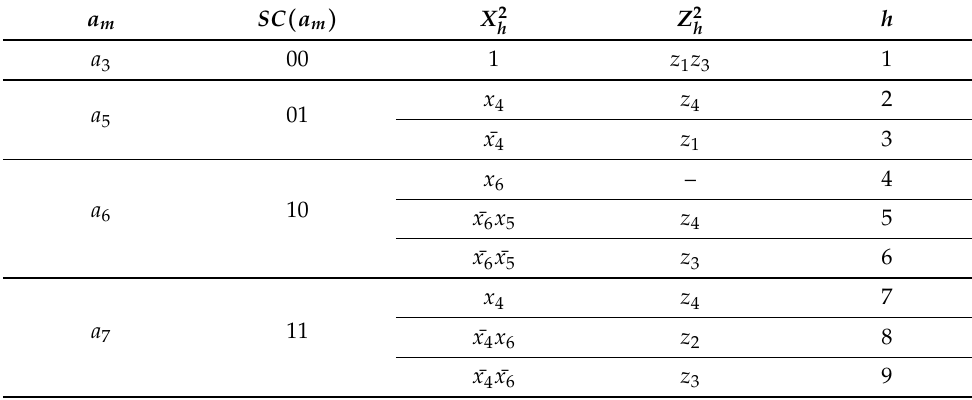
Table 5. Table of LUTerZ 2.